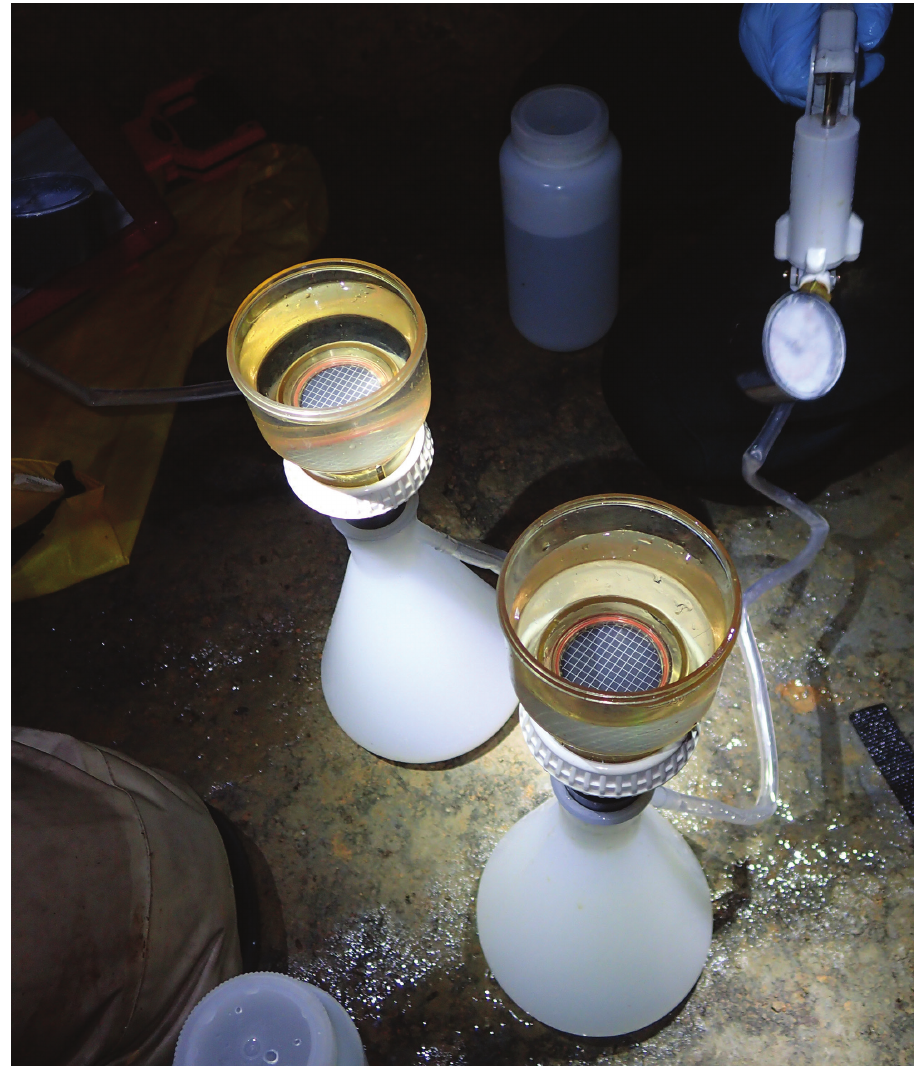
Figure 2. Filtration setup for eDNA collection. While wearing gloves, a 0.45-µm microbial filter was placed inside a filter funnel that was attached to a vacuum flask via a rubber stopper. A hand pump was used to create a vacuum and pull water through the filter. Filters were stored at room temperature in vials of 900 µl of Longmire’s buffer (Longmire et al.